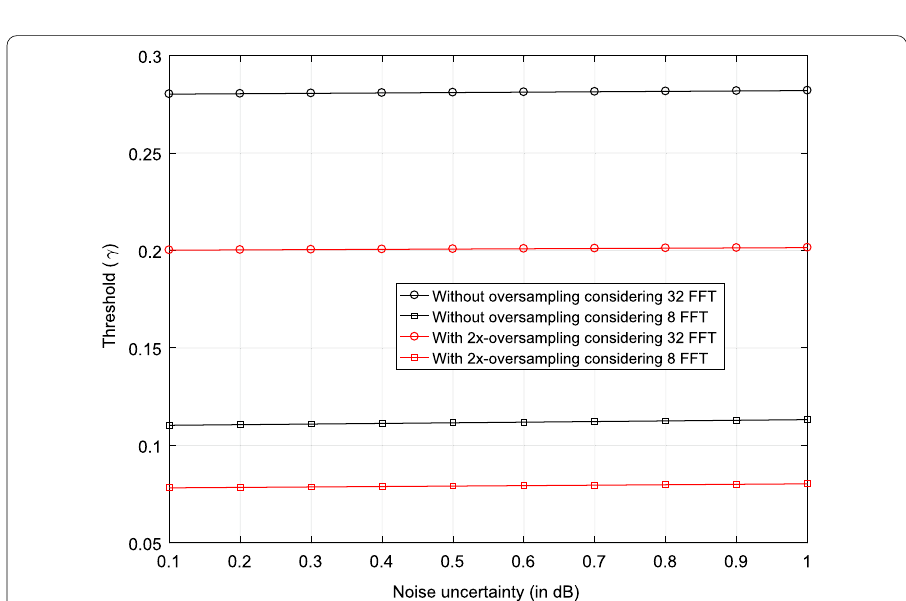
8, and the number of sampling =